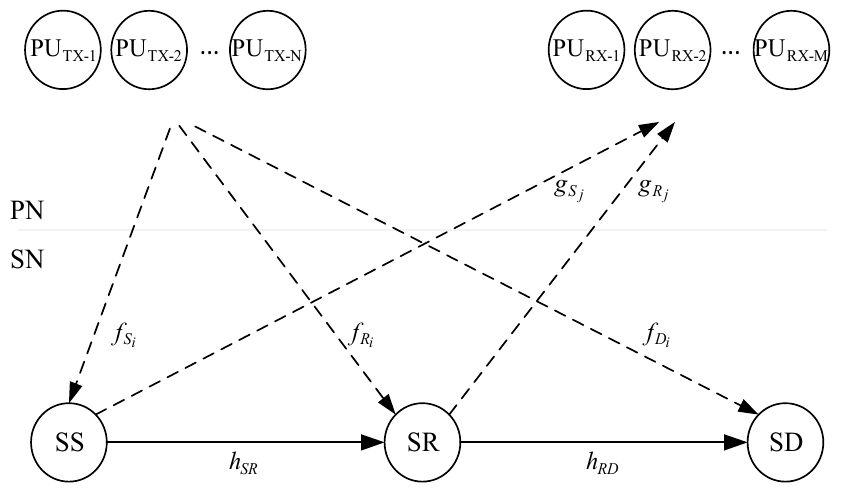
Figure 1. Model of the underlay cognitive relay network.